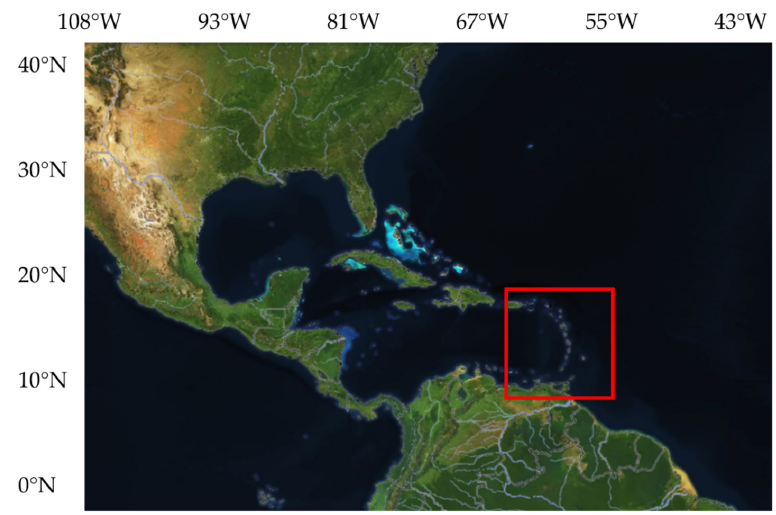
Figure 1. General overview of the area of interest in the Caribbean Sea (red square).